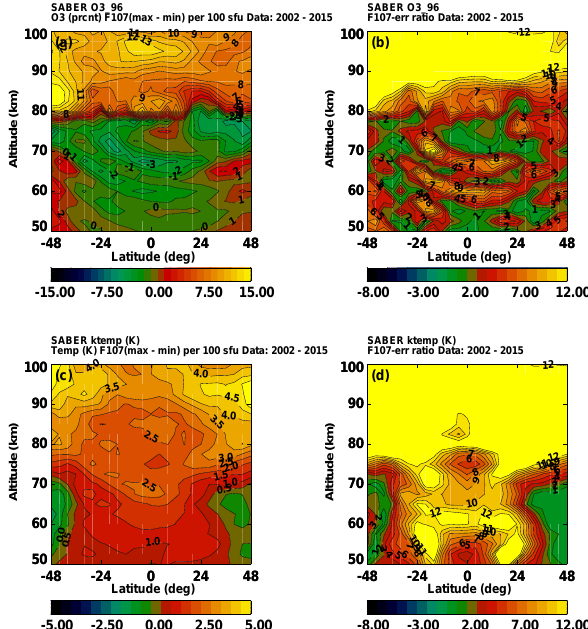
Figure A1. Top row: ozone solar responses (top left) and ratios to their respective uncertainties (top right). Bottom row: corresponds to top row but for temperatures. The brown colors separate those within the 95% confidence (2 σ , red, yellow) from others